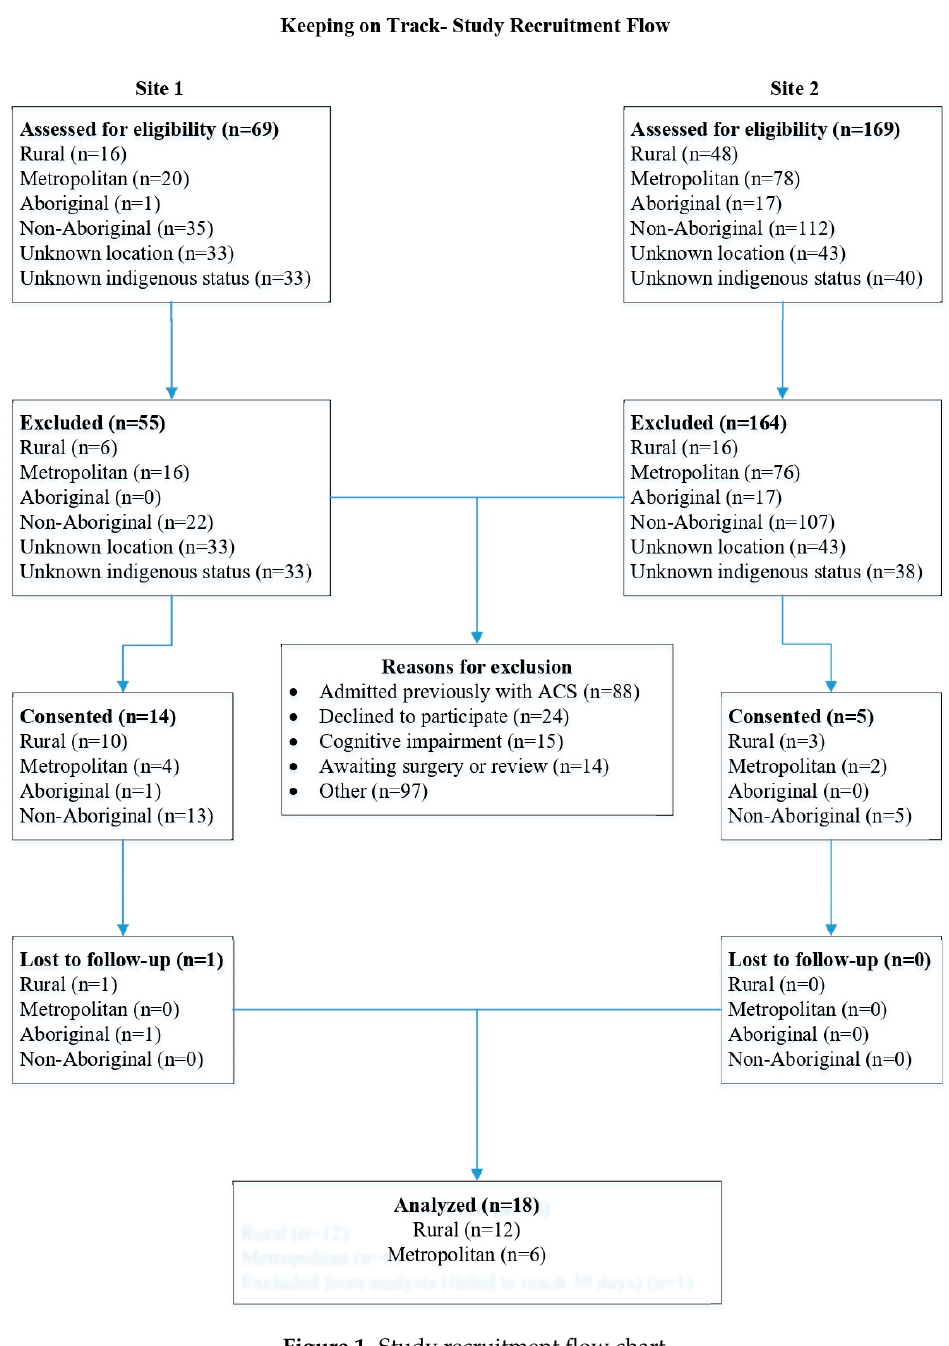
Figure 1. Study recruitment flow